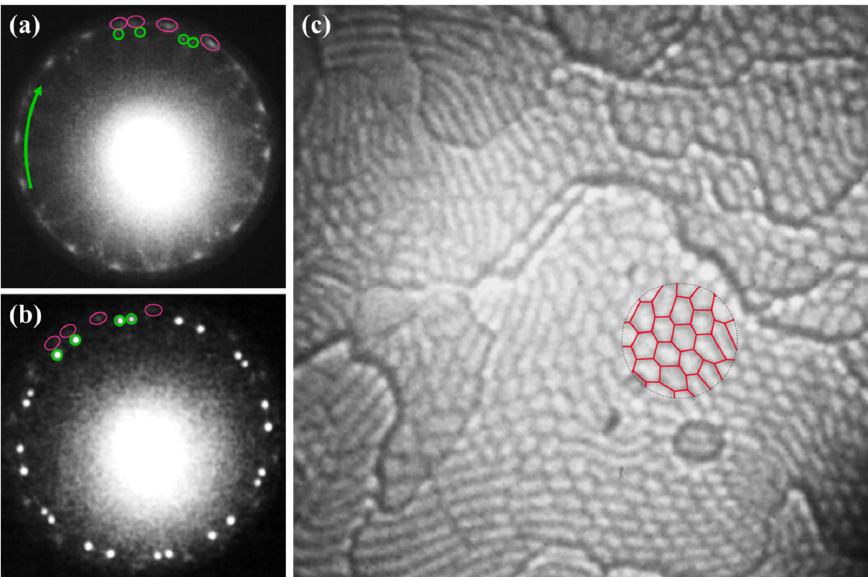
Figure 3. LEED patterns showing thermal development of low buckled and planar silicene recorded at 435 K ( a ) and 465 K ( b ). Green arrow in ( a ) indicates a ring with an additional set of diffraction spots representing planar silicene. Diffraction spots of four domains of both phases of silicene are marked by pink loops (low buckled) and green circles (planar). ( c ) Corresponding LEEM image with polygon-shaped features of planar silicene mesh recorded at RT, 1 × 1 µ m 2 . In the central part, a red mesh showing polygon edge domains is superimposed. LEED patterns and LEEM images collected at E = 14.2